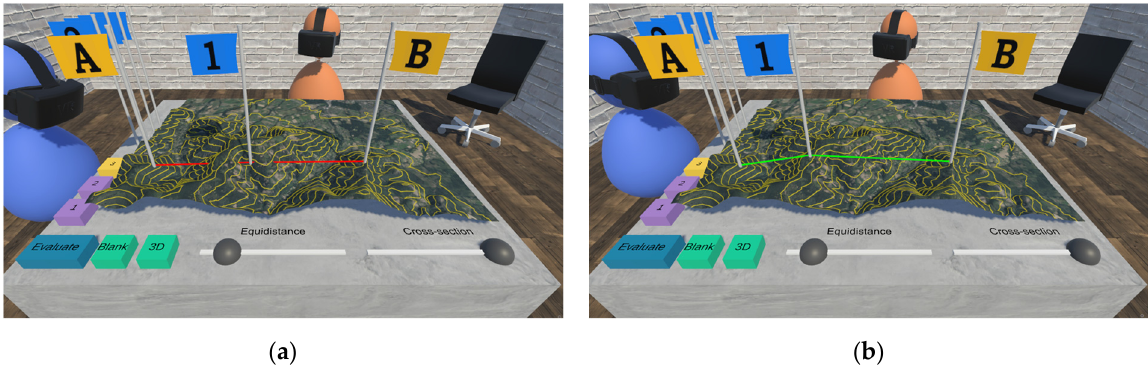
Figure 2. Evaluation of direct visibility. ( a ) Incorrect ( b ) and correct connecting startpoint (A) and endpoint (B). Direct visibility is not ensured between points A and B in the left figure, unlike in the right figure, where the flag is placed on the top of the ridge. Table 1. Guided and unguided task